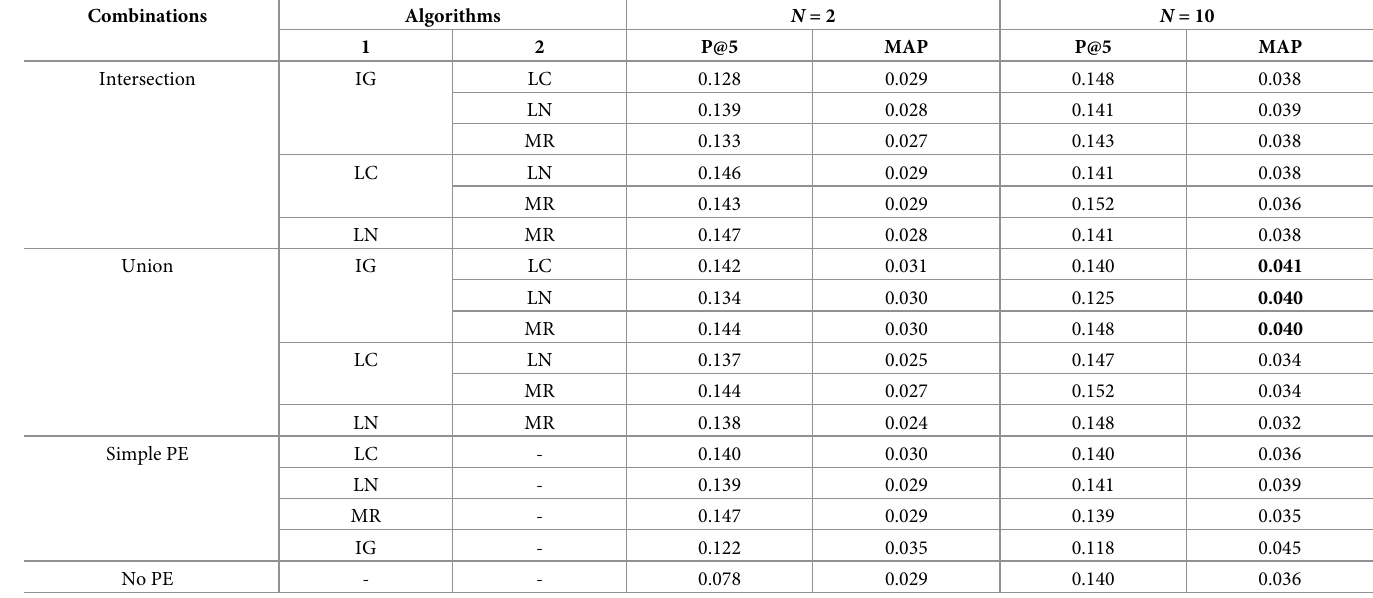
Table 3. P@5 and MAP for High Order Profile Expansion parallel alternatives. Intersection alternative with l = 5 for all the algorithms but IG, with l = 100. Union alter- native with l = 2 for all the algorithms. Results for simple Profile Expansion techniques are also shown, with l = 5. Significant improvements over the MR algorithm (when N = 2) and the algorithm without PE (when N = 10) are